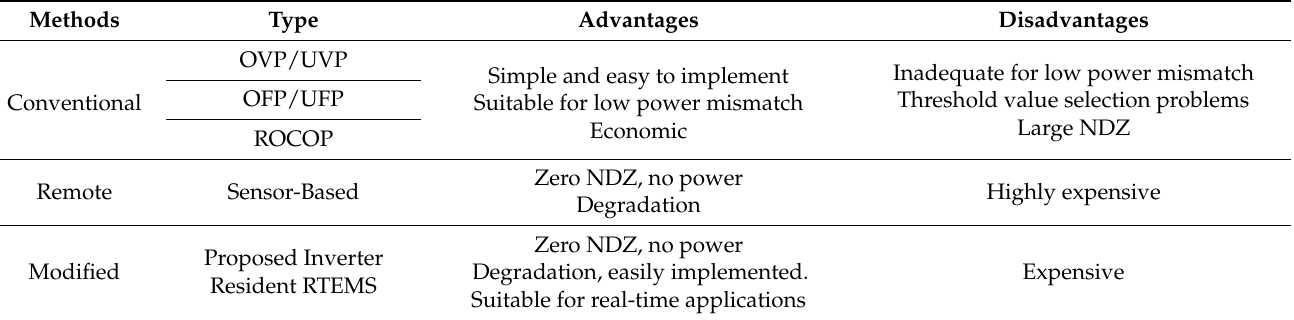
Table 1. Performance comparison of existing islanding detection methods